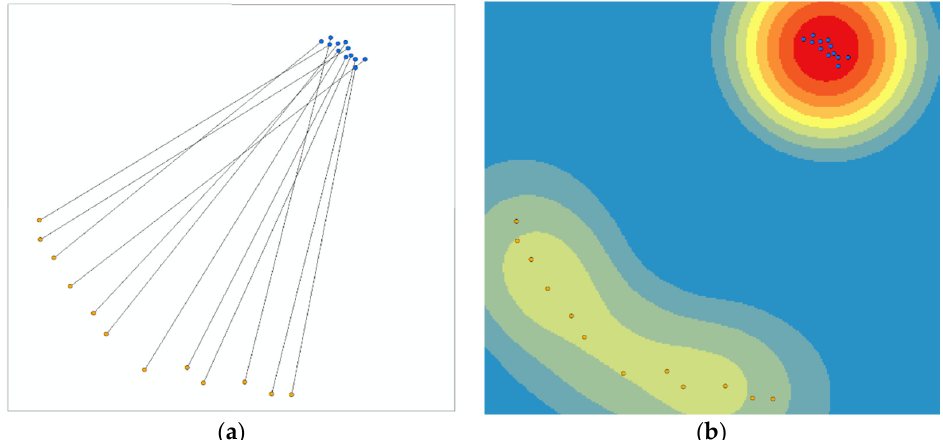
Figure 13. ( a ) OD flows and ( b ) kernel density distribution of OD points in geographical space.